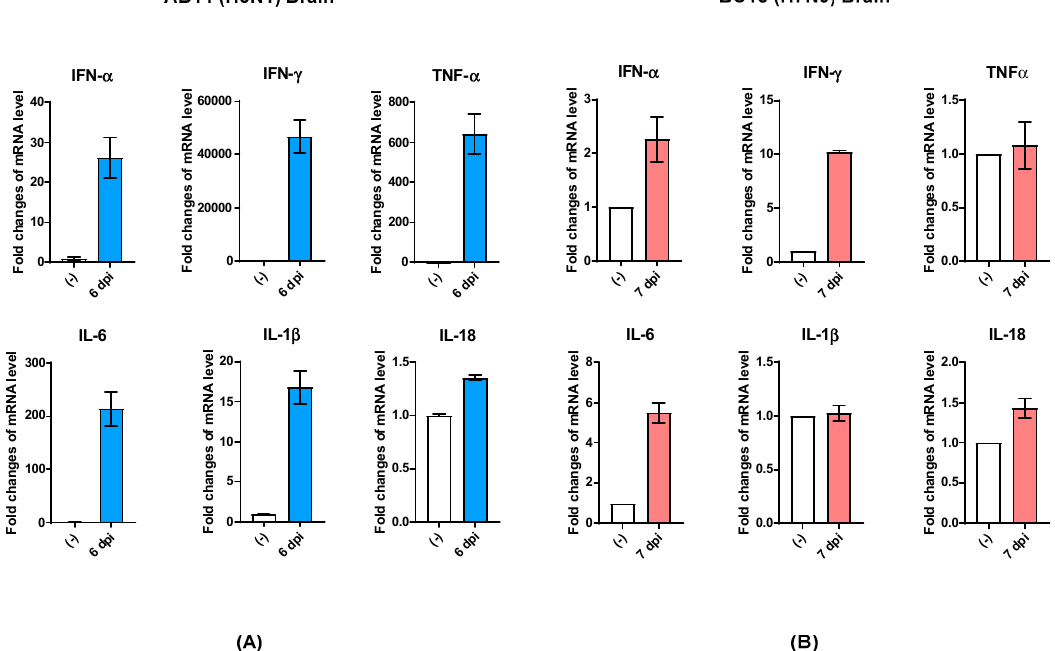
Figure 5. Cytokine gene transcription profile in the brains of mice infected with the AB14 (H5N1) and BC15 (H7N9) strain isolates. Cytokine transcription levels of IFN- α , IFN- γ , TNF- α , IL-6, IL-1 β , and IL-18 from virus-infected brains with ( A ) AB14 (H5N1) and ( B ) BC15 (H7N9) ( n = 3 mice per virus group). Samples were harvested on the indicated d.p.i; each sample was tested in triplicate.